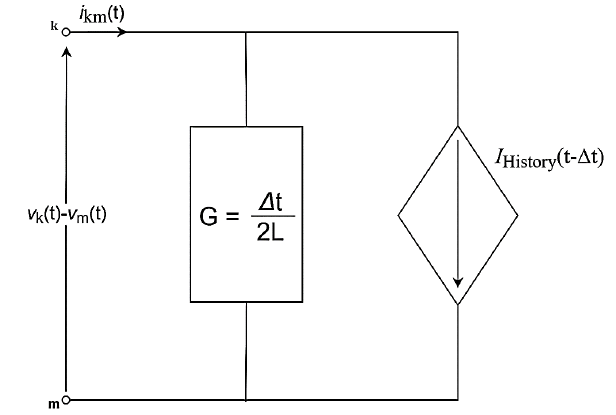
Figure 5. Discrete model of the